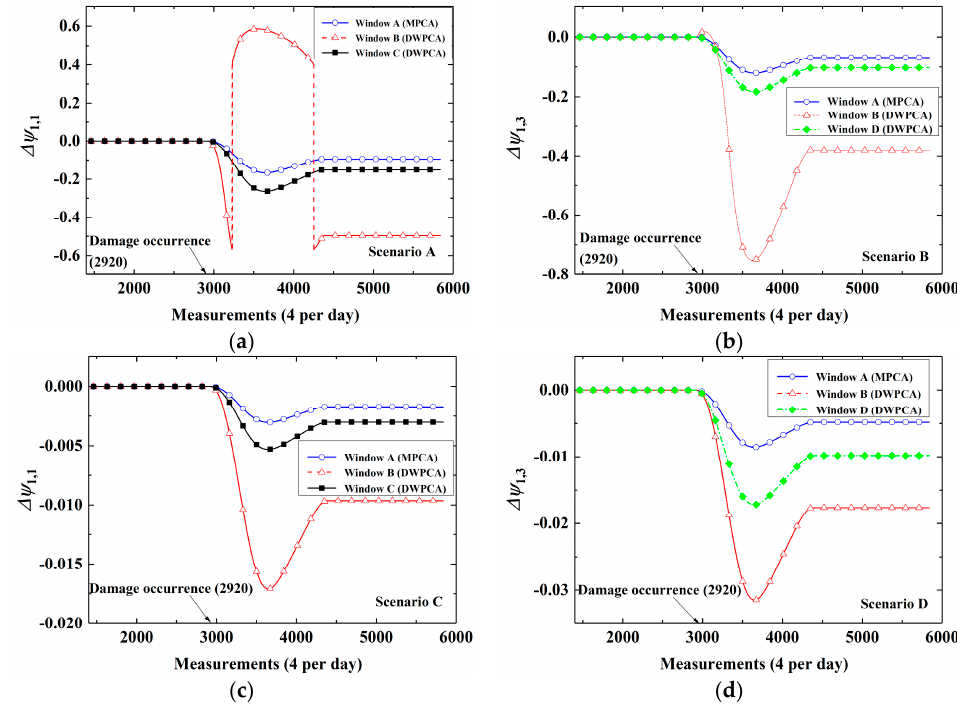
Figure 6. Evolution of CEVs for different space windows: ( a ) Scenario A; ( b ) Scenario B; ( c ) Scenario C; ( d ) Scenario D. ( d ) Scenario